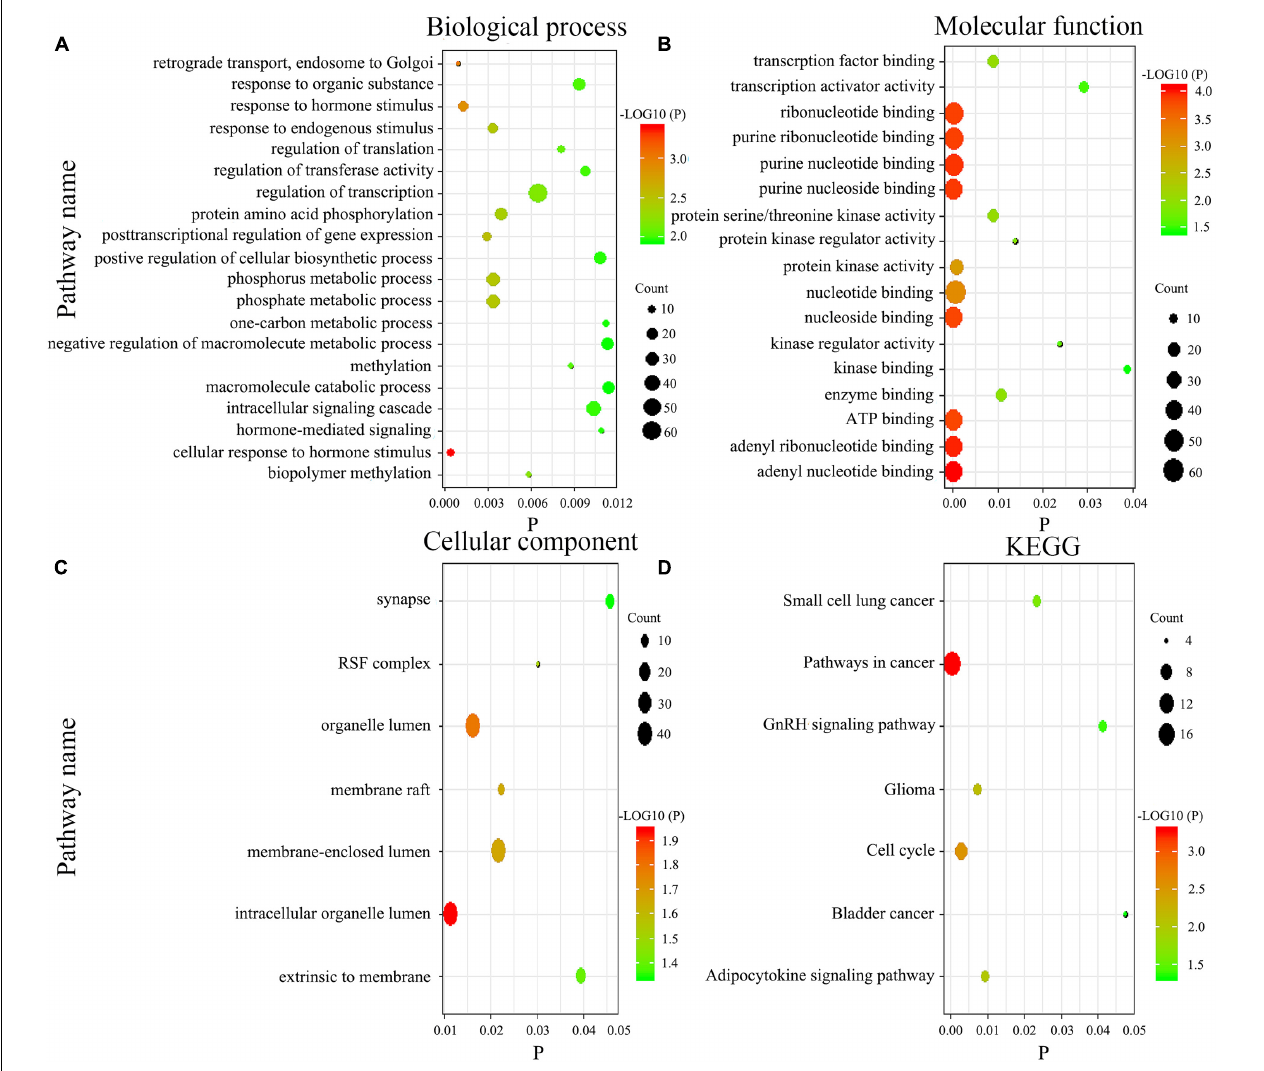
FIGURE 7 | Gene enrichment analysis and Kyoto Encyclopedia of Genes and Genomes (KEGG) pathways for the genome-wide network. The biological process (A) , molecular function (B) , cellular component (C) , and KEGG pathways (D)